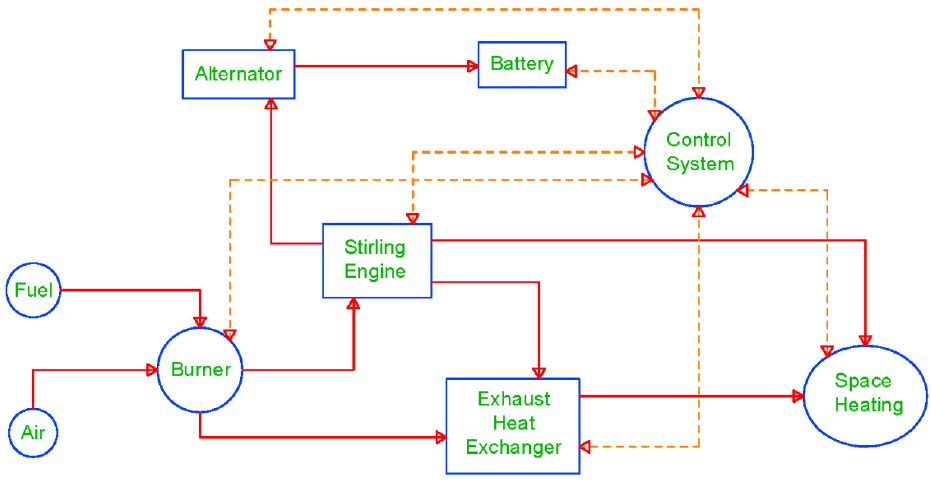
Figure 1. Operational scheme of the Stirling CHP